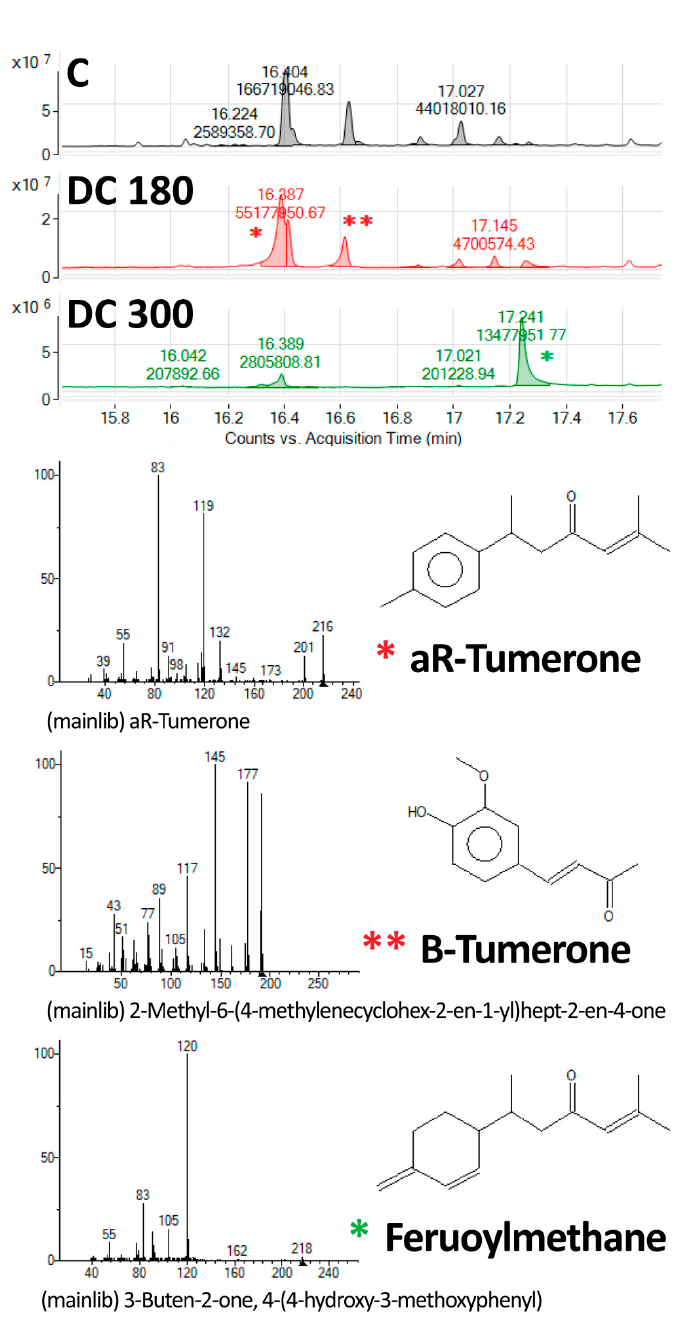
Figure 4. GS–MS analysis of untreated curcumin powder (C), and curcumin degraded at 180 °C (DC 180) or at 300 °C (DC 300). The main products of curcumin degradation were aR-tumerone ( * ), B-tumerone ( ** ), and feruoylmethane ( * ). Upper part: total counts between 15.8 and 17.6 minutes of the acquisition time; lower part: details of the peaks with systematic chemical formulas and schemes of the molecules of curcumin and its degradation